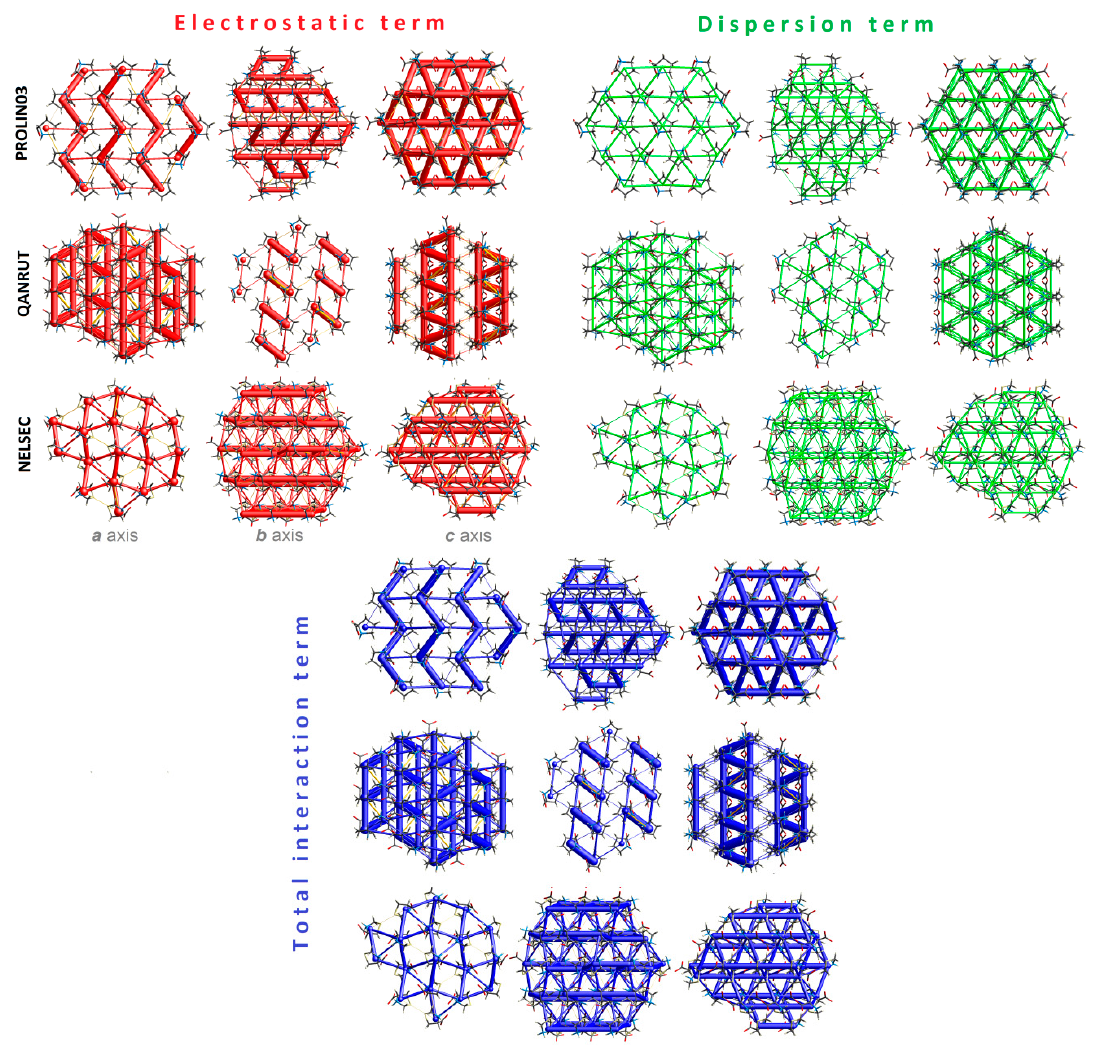
Figure 19. Energy frameworks of proline structures corresponding to the electrostatic and dispersion energy components and the total energy framework along a, b and c -axis (the tube size: 300).